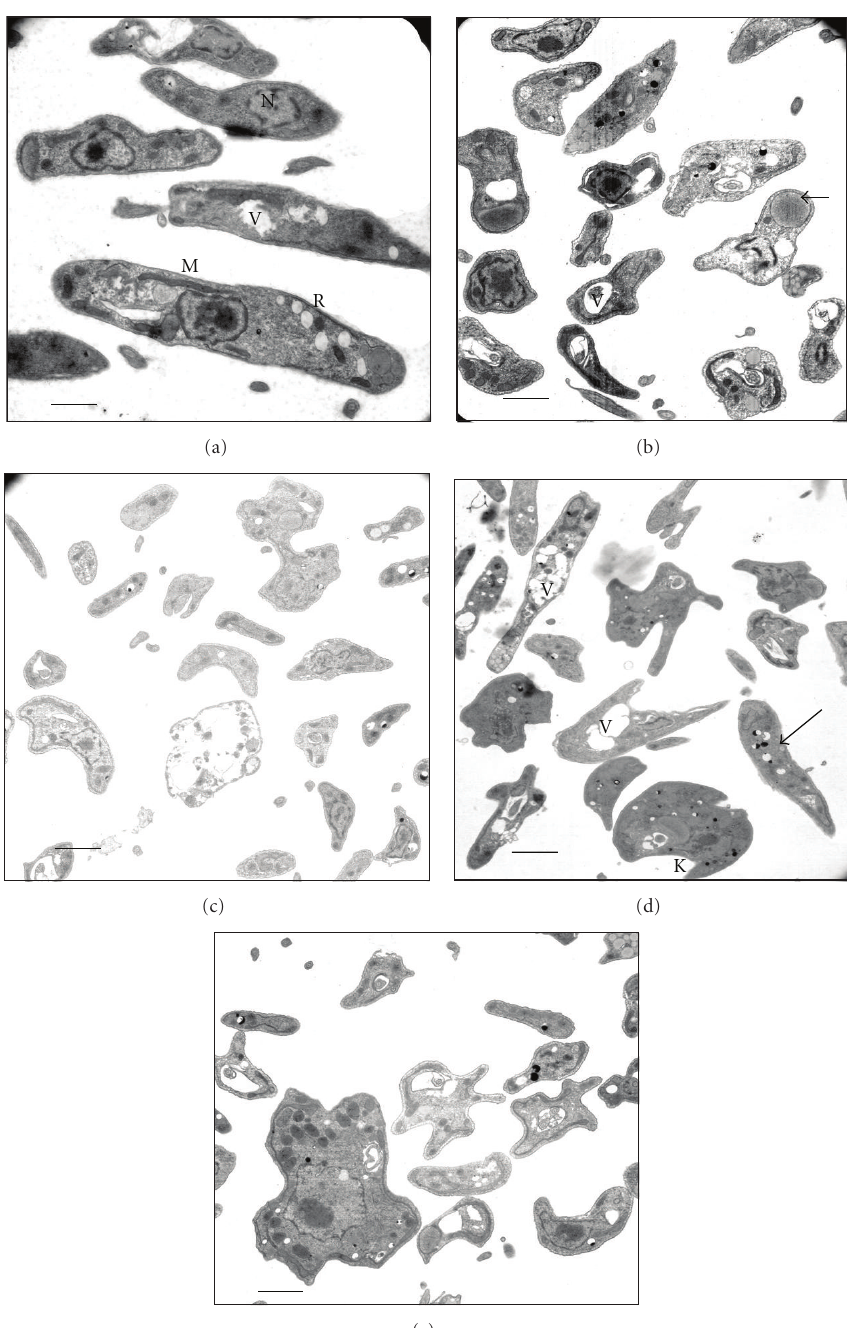
Figure 5: Ultrastructural alterations by TEM in L. braziliensis treated with flavonoid derivatives. (a) Control parasite of L. braziliensis with structures such as the nucleus (N), reservosomes (R), vacuoles (V), and mitochondrion (M) (bar: 1 μ m). (b) L. braziliensis treated with compound 4 with vacuoles (V) and swelling kinetoplast (arrow) (bar: 1 μ m). (c) L. braziliensis treated with compound 6 (bar: 1.59 μ m). (d) L. braziliensis treated with compound 7 with intense vacuolization (V), electrodense organelles (arrow), and swelling kinetoplast (K) (bar: 2.33 μ m). (e) L. braziliensis treated with compound 8 with distorted forms (bar: 1.59 μ